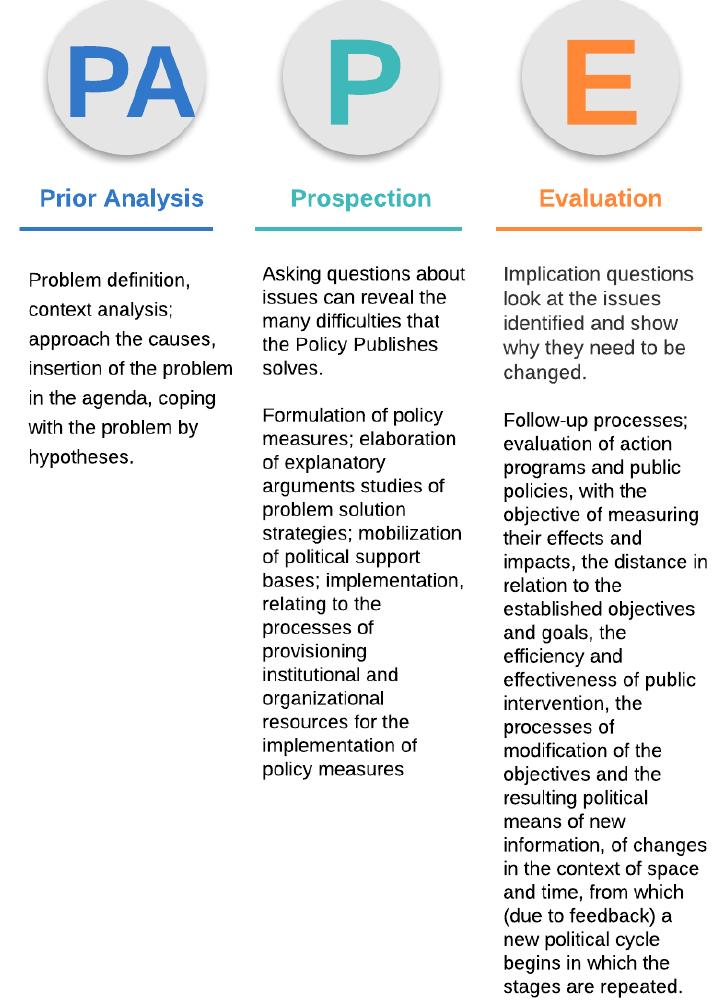
Table 1. Overview of public policy categories corresponding to their social aspects according to Lowi ’ s classification [8].